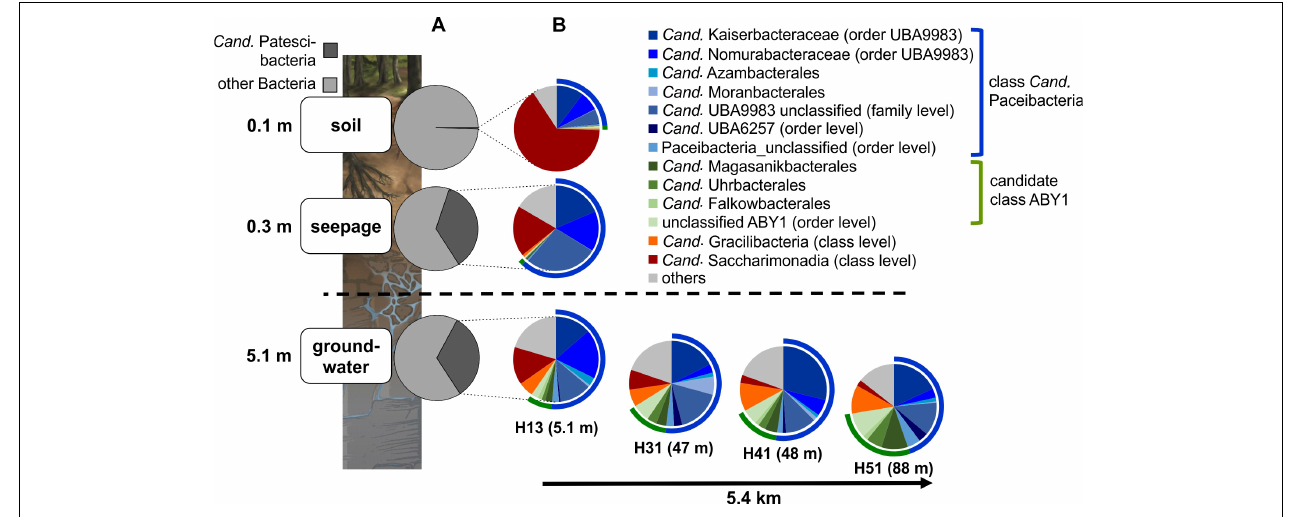
FIGURE 4 | Community structure of Cand . Patescibacteria in soil, seepage and groundwater. (A) Changes in the relative fraction of Cand . Patescibacteria within the bacterial communities from soil via seepage to groundwater and (B) changes in the order-level community structure of Cand . Patescibacteria (family level for Cand . Kaiserbacteraceae, Cand . Nomurabacteraceae and unclassified UBA9983; class level for Cand . Gracilibacteria and Cand . Saccharimonadia) from soil to seepage and groundwater and along the groundwater observation transect (lower aquifer assemblage). Data are based on 16S rRNA gene-targeted Illumina MiSeq amplicon sequencing and represent mean values of 10 spatial replicates for soil, mean values from five lysimeters with each one sampling time point except for H1L1-2 ( n = 6) (total n = 11), and one (H13), two (H31) or six different sampling time points for groundwater (total n = 15). Seepage and groundwater samples integrate data from the 0.1 and 0.2 µ m filter fractions.